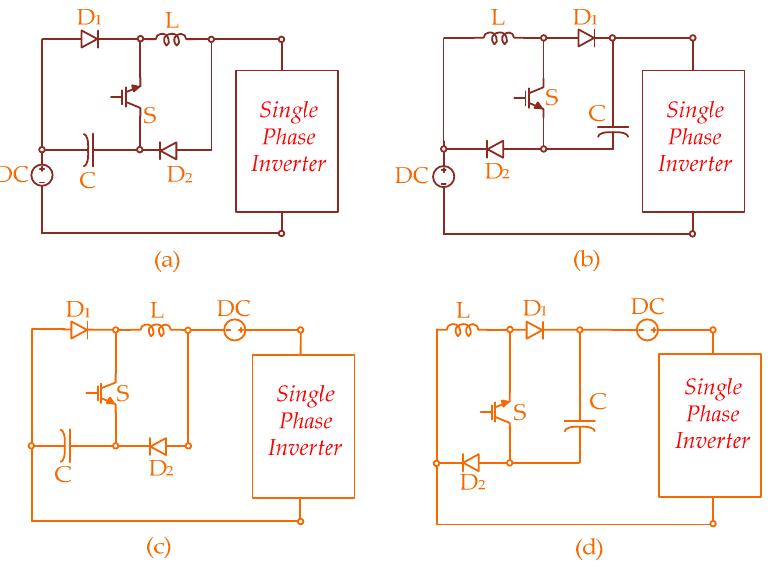
Figure 5. DC-Link quasi-switched boost topologies ( a ) For negative bus type 1; ( b ) For negative bus type 2; ( c ) For positive bus type 1; ( d ) For positive bus type 2.